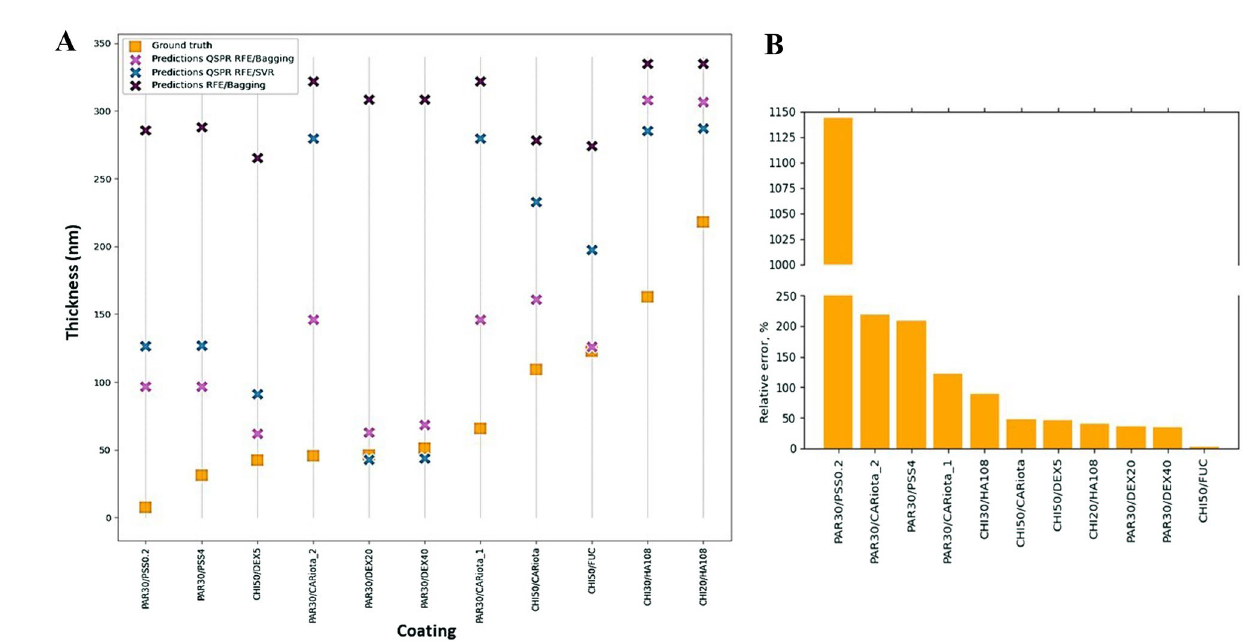
Figure 6. ( A ) Real (ground truth) and predicted thickness of coatings in the validation data set. ( B ) Relative errors for predictions made with the best of constructed models (QSPR